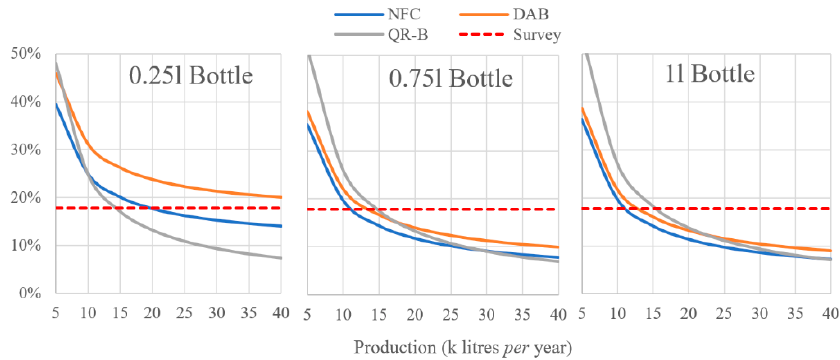
Figure 2. Variation of the increase in cost (in %) per bottle, at farm level only, for three systems in relation to the annual oil